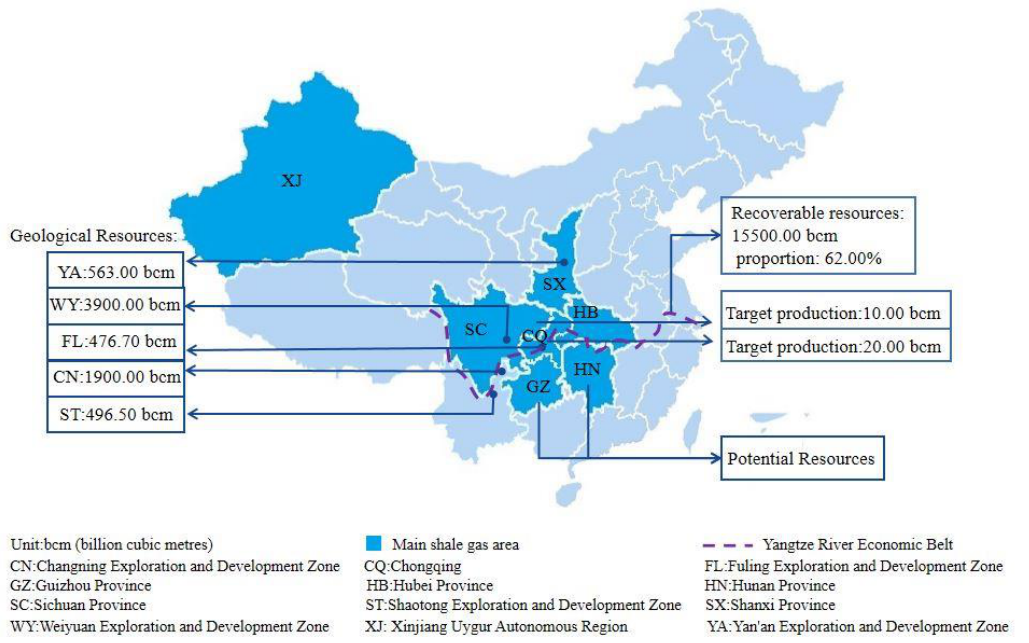
Figure 1. Shale gas resource reserves/development goals.